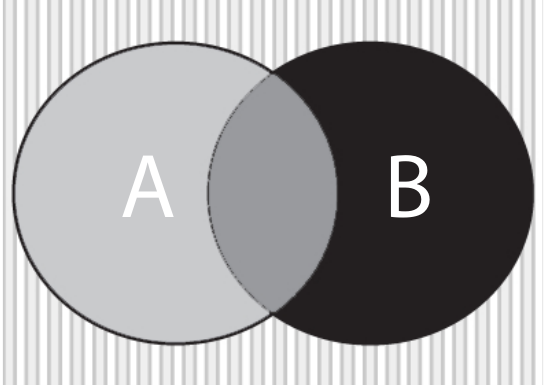
Figure 3. A sequence of polarizers contradicts an axiom of classical probability predicting P ( A ∪ B ) = P ( A ) + P ( B ) − P ( A ∩ B ) . Adding a third polarizer probability can increase intensity in an overlapping region P ( A ∩ B )